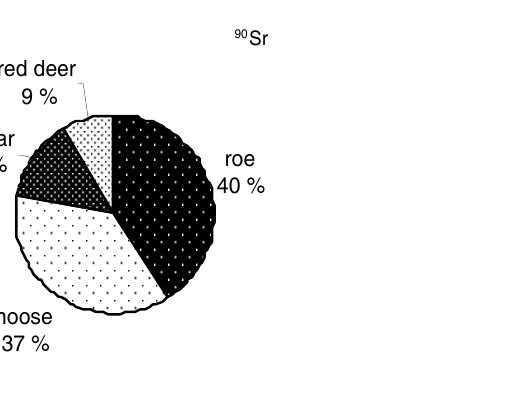
Fig 2. Components of total average annual effective dose for hunters and members of their families due to 90 Sr and 137 Cs in meat of game, in percent